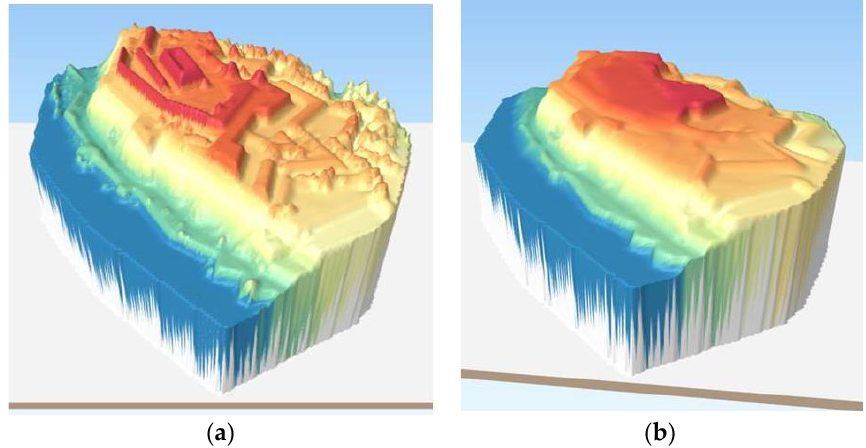
Figure 7. Display of DEM data in GIS. ( a ) Original; ( b ) After integrity violation.